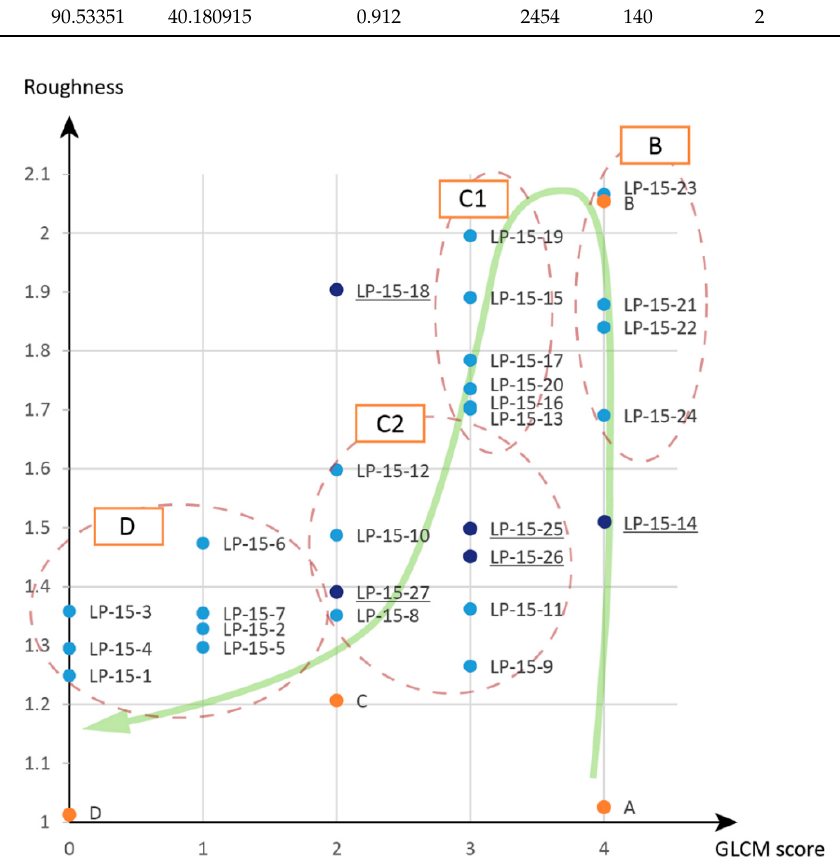
Figure 5. Salt crust microrelief projected on a gray-level co-occurrence matrix (GLCM) roughness graphic. In this plot, GLCM score is on the x-axis, roughness is on the y-axis, and light blue points mark the positions of salt crust conforming with theory, whereas dark blue points with underline labels require further discussion. The four ideal surface models are labeled here with orange dots. On the basis of clustering features, red dotted lines and orange boxes denote the evolution of salt crusts at the sample sites indicated by the two indexes, whereas green lines with arrows mark the tendency of this evolutionary process.